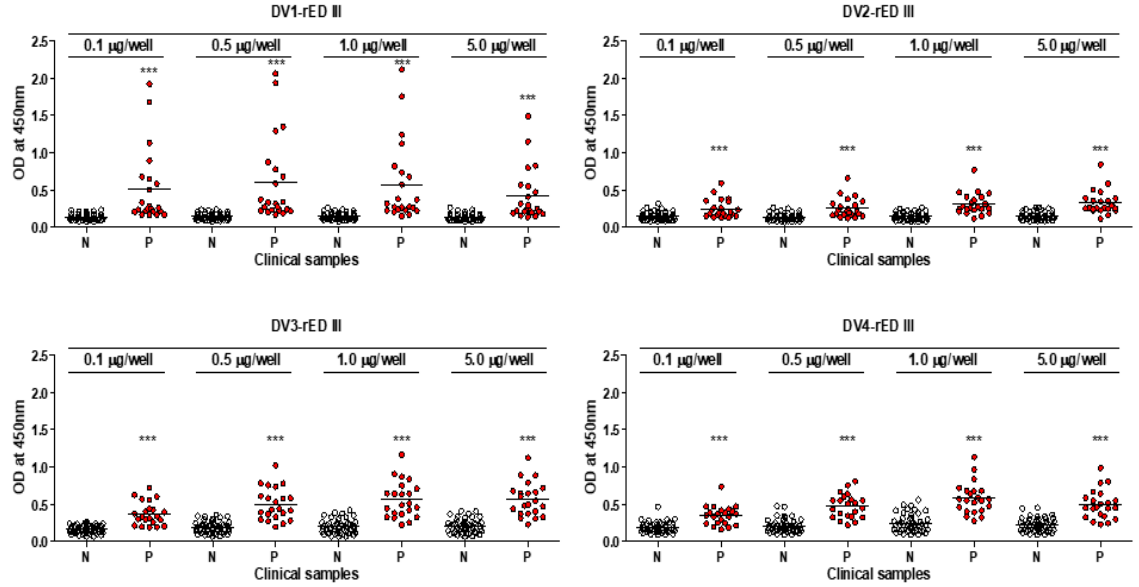
Figure 4. Clinical validation of antigen-linked ELISA with patient specimens. The dengue-negative sera, indicated as N ( n = 46), and dengue-positive patient sera, indicated as P ( n = 22), were applied in ELISA. Different amounts of antigens at 0.1, 0.5, 1, and 5 µg/well were tested with clinical samples and plotted in graph. ***, P < 0.001.